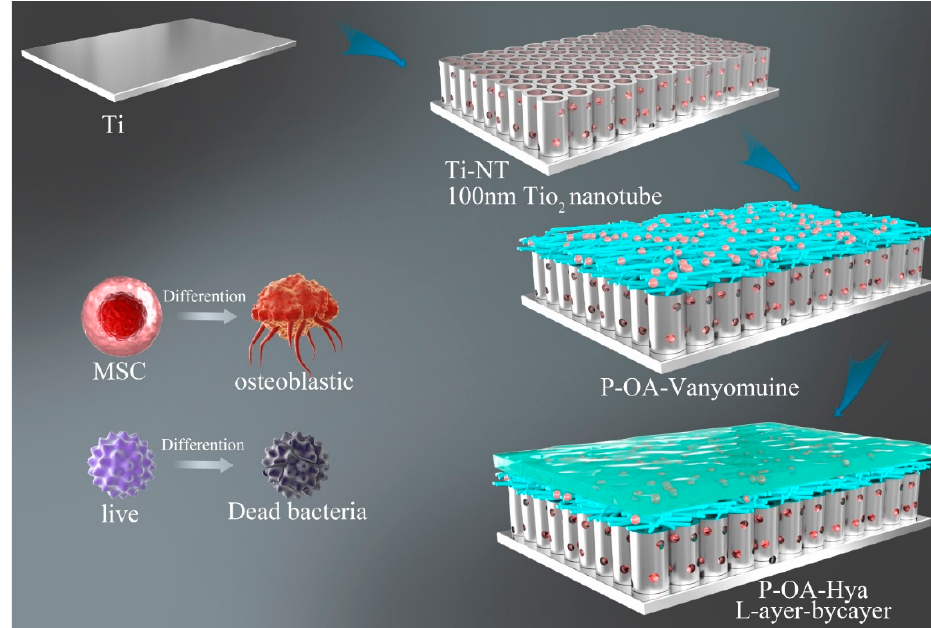
Figure 2. Ti rod surface coated with a Ti coating through a hole-structure pattern: ( A ) structure diagram; ( B ) SEM before drug loading; ( C ) SEM after drug loading. Ti coating spray (pure Ti coat- ing), plasma spray with the placeholder filler metal etching method, and spraying preparation so- lution (with a through hole design Ti coating) were utilized. Vancomycin was loading through the hole pattern structures between the Ti coating [105].